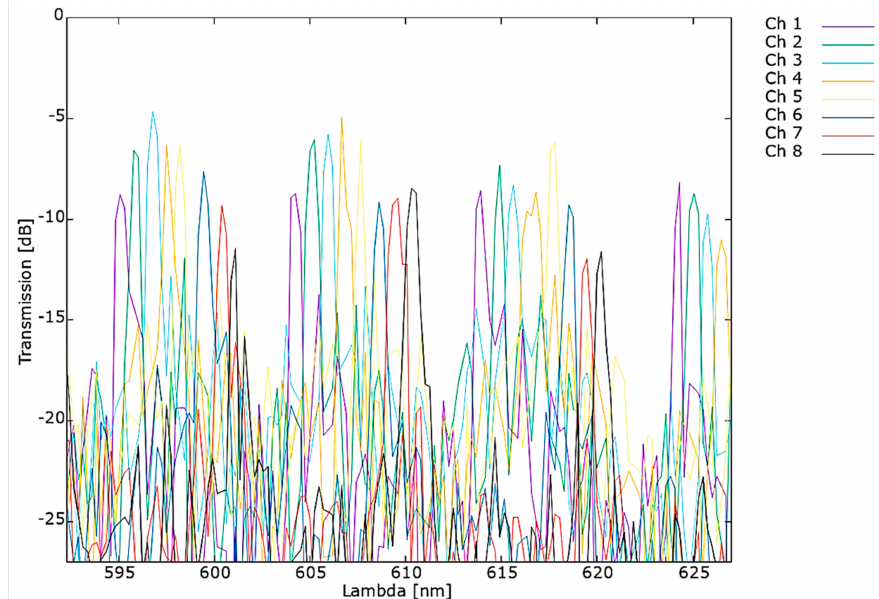
Figure 23. Measured spectrum of AWG 1 × 8 optimized for 610 nm transmission.